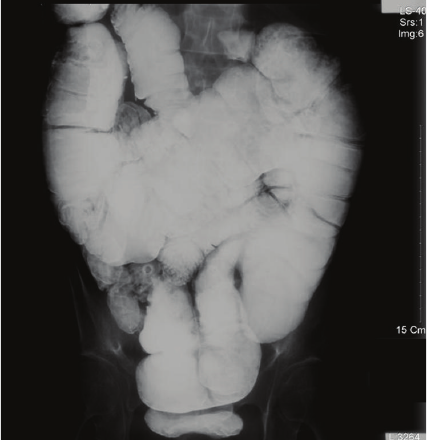
Figure 1: Upper gastrointestinal series show the small intestine about 40cm (red line).